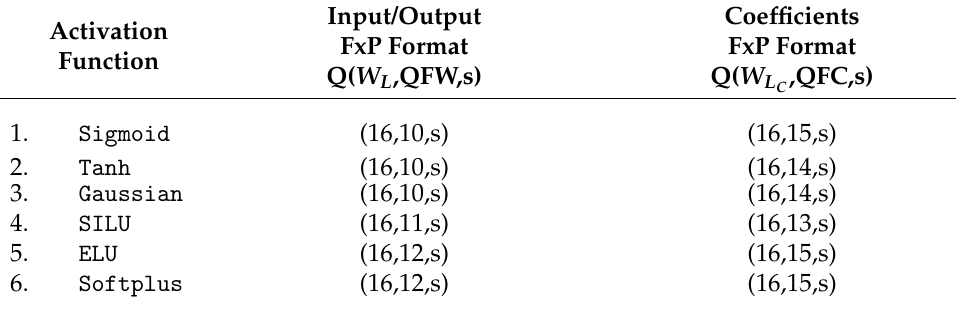
Table 2. FxP format for implementing AFC in